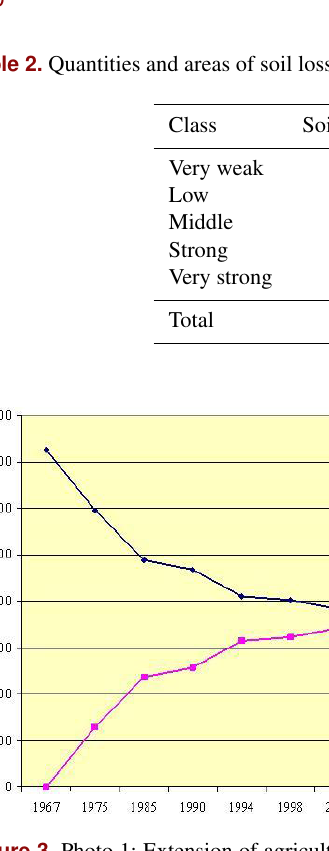
Figure 3. Photo 1: Extension of agricultural space and its removal by stone removal, which contributes to erosion (Evolution of Mo- hammed V dam’s siltation (Agence du Bassin Hydraulique de la Moulouya, Oujda, Maroc)).